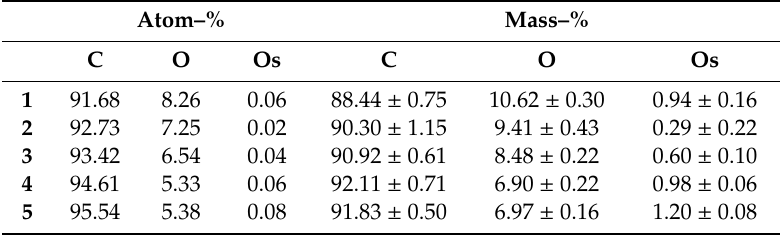
Table 5. Element composition of the cell wall regions measured with STEM-EDS (Figure 8). Atom–%